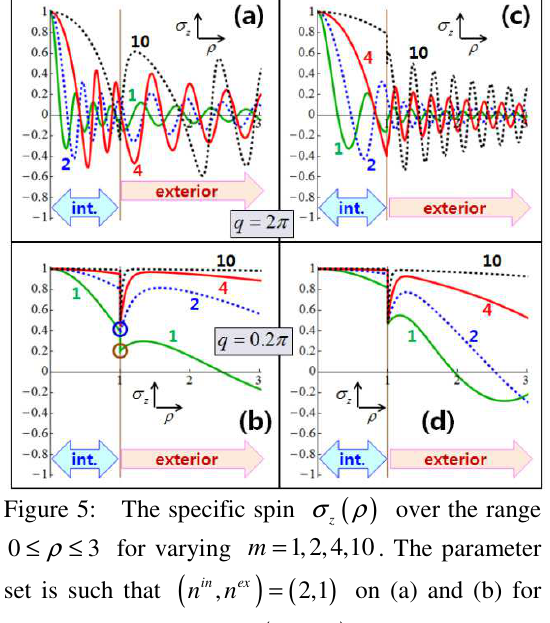
σ ρ over the range z